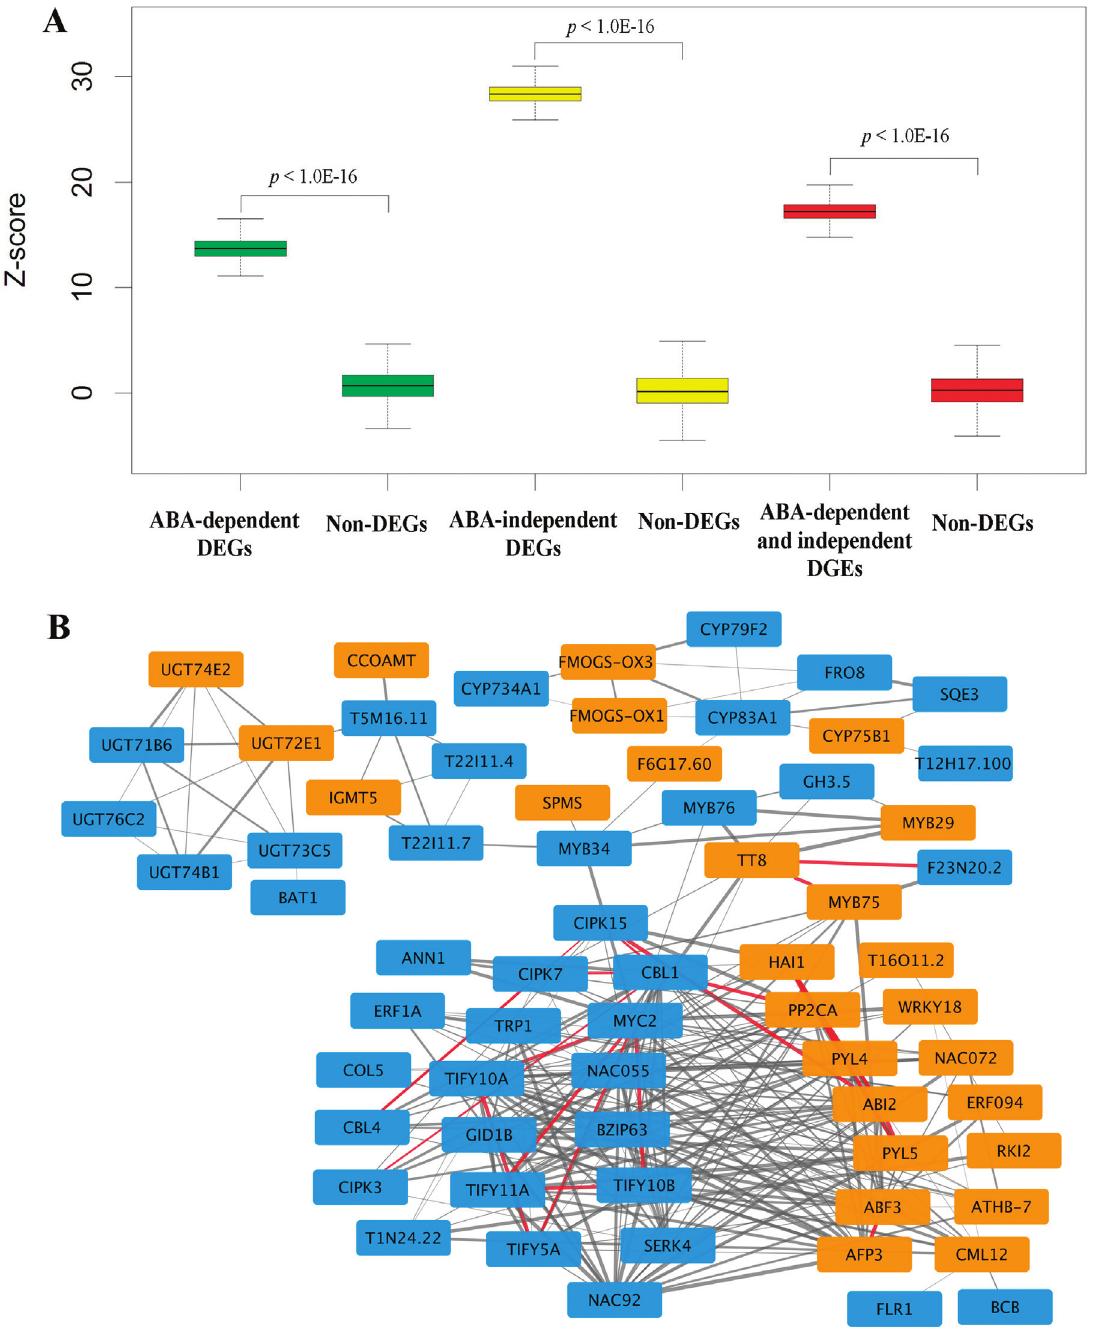
Figure 4 - Interaction analysis between ABA-dependent and ABA-independent drought-responsive genes. (A) Statistical significance of the global inter- actions between ABA-dependent and ABA-independent drought-responsive genes. The significance of interactions among drought-responsive gene sets was calculated using t-tests by comparing the Z-scores of the interactions of DEGs and non-DEGs. The random gene sets were selected from the pool of Non-DEGsofthesamesizeasthedrought-responsivegenesetstocalculatetheZ-score.Theboxplotsindicateinter-quartilerangesofthedata.Thebarin each boxplot indicates the median. (B) Network view of interaction between ABA-dependent and ABA-independent drought-responsive genes. ABA-dependent DEGs are depicted in orange, and ABA-independent DEGs are depicted in blue. The interactions connecting the nodes are represented by color-coded lines according to the experimental verification status. Gray represents the predicted interaction without experimental verification; red represents the predicted interaction with experimental verification. The line width represents the probability of the protein pairs